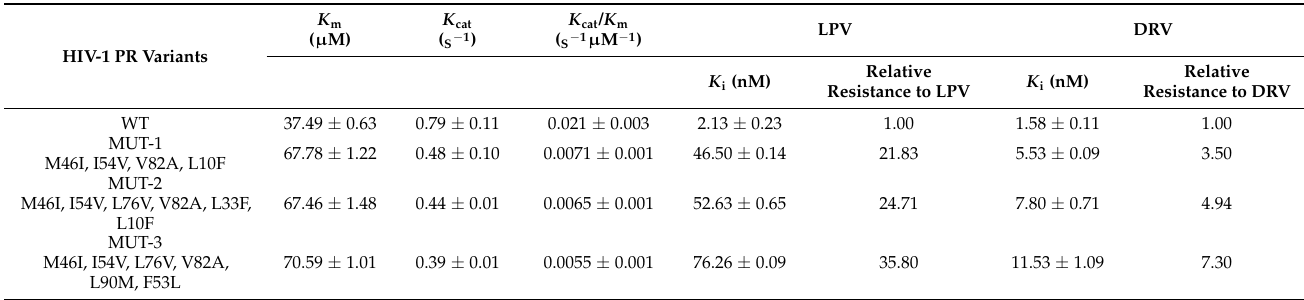
Table 1. Wild type and mutant HIV-1 PR variants enzyme kinetic parameters ( K m , K cat ) and inhibition constant (K i ) calculated using the chromogenic